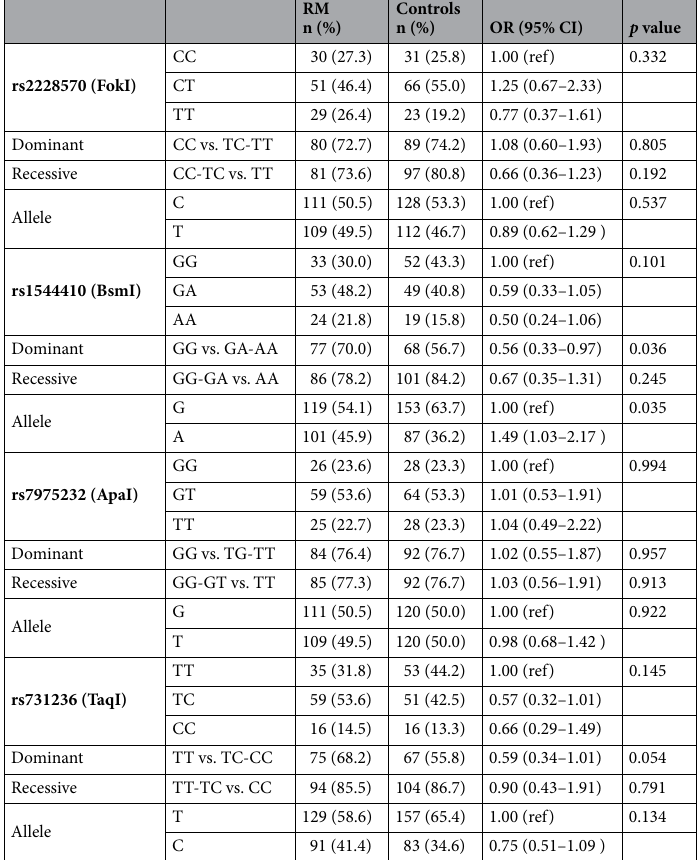
Table 2. Genotype and allele frequencies of VDR polymorphisms among RM cases and controls. OR odds ratio, CI confidence interval. p value chi-square test.